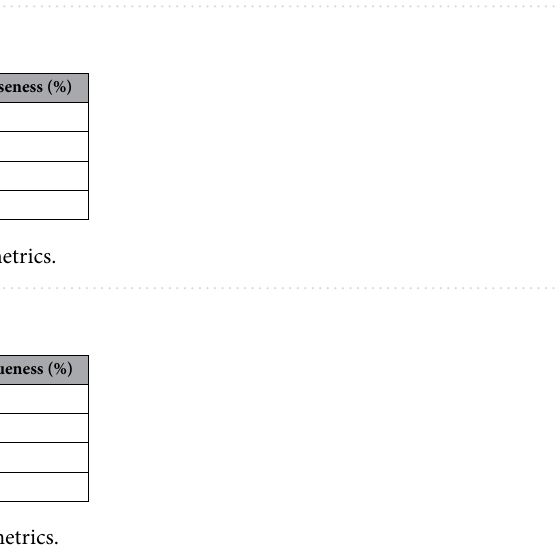
Table 6. PUF performance uniformity metrics.